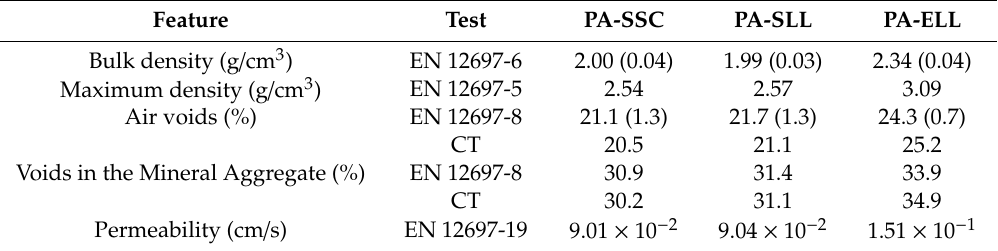
Table 5. Volumetric properties: Average and standard deviation